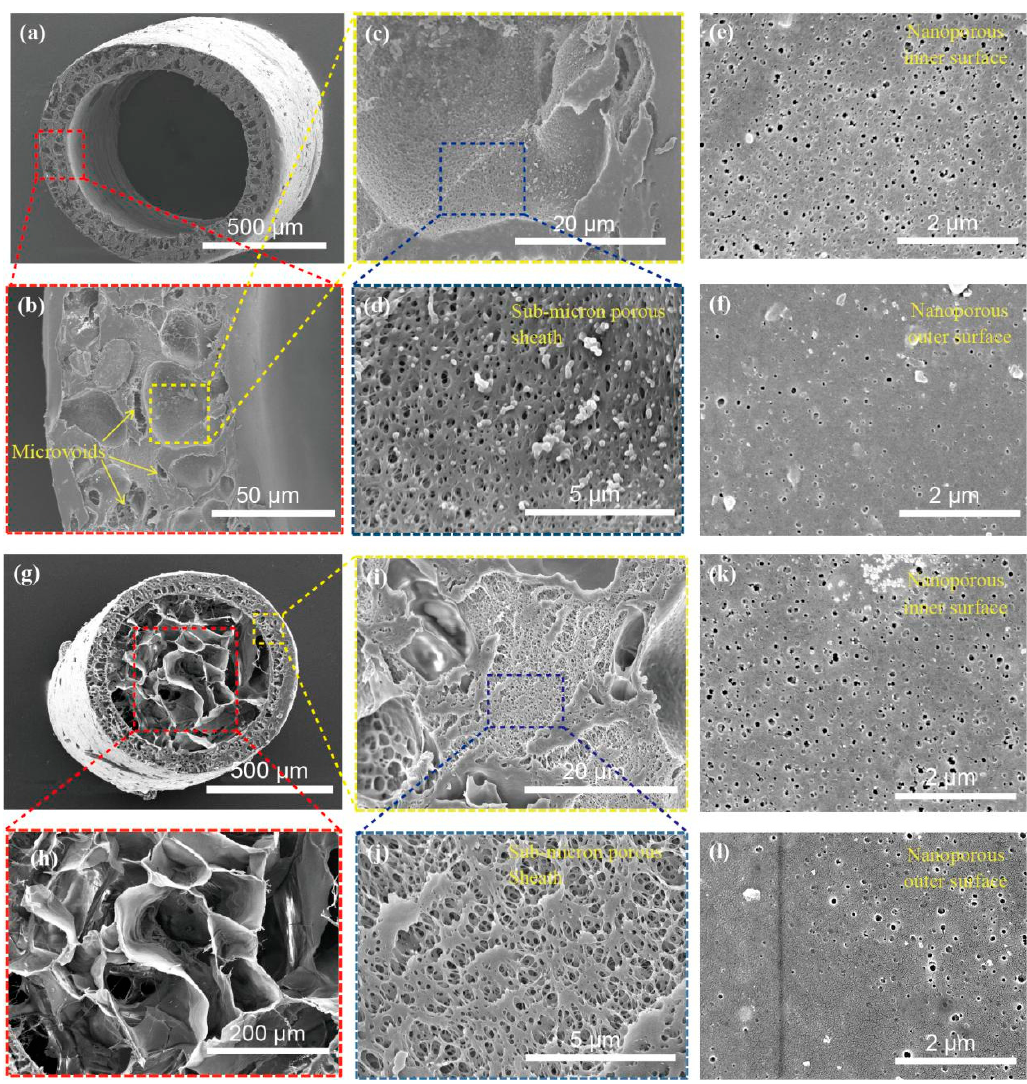
Figure 2. SEM images of hollow and aerogel fibers. ( a – d ) The cross-section morphology of CA/PAA hollow fiber with ×80, ×800, ×2.5k, ×10k, respectively; ( e , f ) the inner and outer surfaces of the hollow fiber showing nanoporous structures; ( g ) the aerogel fiber cross-section showing porous sheath and core; ( h ) the SF aerogel core of the aerogel fiber; ( i , j ) the sheath in aerogel fiber showing similar micro-voids structures as in the hollow fiber sheath; ( k , l ) the inner and outer surfaces of the aerogel fiber sheath showing nanoporous structure.